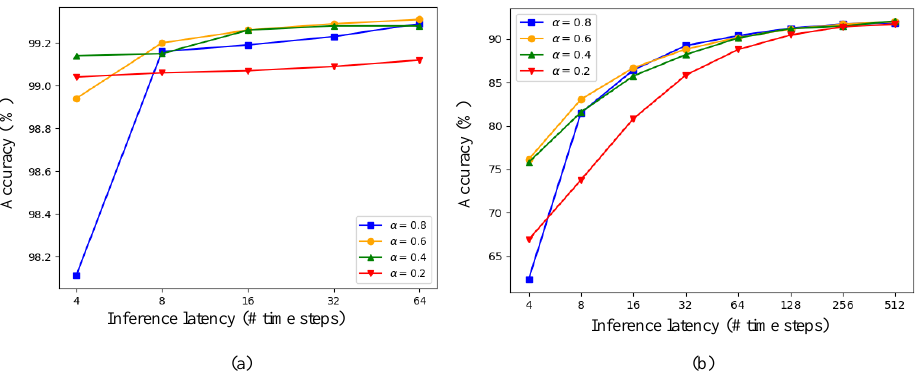
Figure 9. Inference performance with different scaled thresholds on both datasets. ( a ) MNIST dataset; ( b ) Fashion-MNIST.